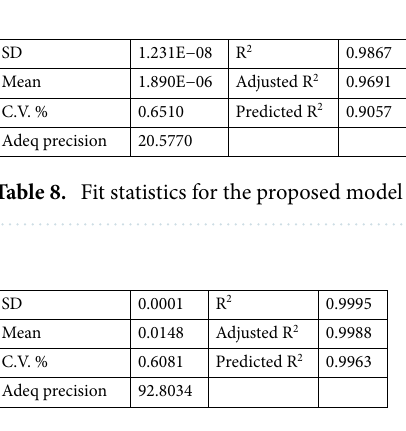
Table 9. Fit statistics for the proposed model for low permeability region.